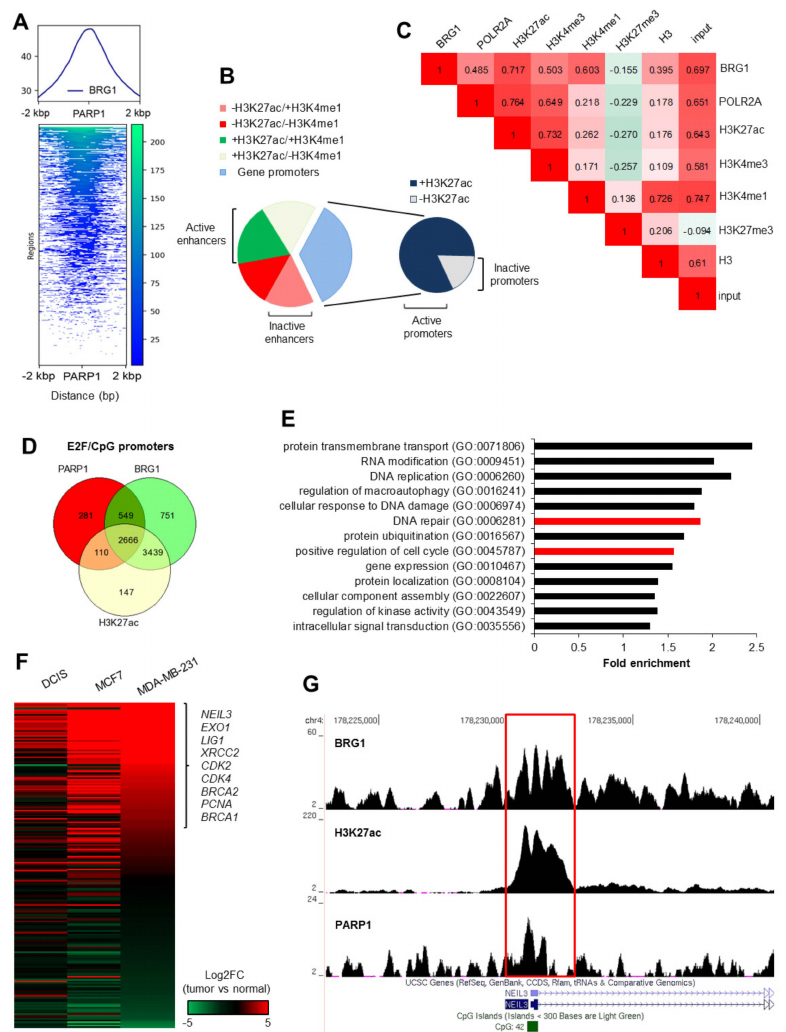
Figure 2. PARP1 co-occurs with BRG1 at the promoters of transcriptionally active genes in MDA-MB-231 cells. ( A ) An example computeMatrix / plotProfile plot of ChIP-Seq data for BRG1. BRG1 peaks are centered at PARP1-enriched regions in the genome of the MDA-MB-231 cell. ( B ) Association of PARP1 / BRG1 peaks with gene regulatory regions shows a prevailing occurrence at the active gene promoters. Enhancers emerged based on H3K27ac / H3K4me1 status, whereas promoters were assumed as TSS ± 2 kbp. PARP1 / BRG1-enriched regions were assigned to particular groups and quantified by bedtools Intersect intervals. ( C ) BRG1 distribution at the PARP1 peaks reveals a relatively strong correlation with histone markers and with POLR2A, which is typical for actively transcribed genes (multiBamSummary / plotCorrelation; PARP1 peaks in bed for scoring). ( D ) Venn diagram showing that a high proportion of PARP1 positive gene promoters are characterized by the presence of BRG1 and strong acetylation of H3K27. ( E ) Triple-positive gene promoters identified in ( D ) represent a functional association with numerous intracellular processes. GO-enriched terms were identified in AmiGO2. ( F ) Di ff erential expression of genes from two selected GOs, i.e., DNA repair and positive regulation of the cell cycle (marked in red in ( E )) in cancer cells (DCIS – ductal carcinoma in situ, pre-invasive malignancy of the breast and two breast cancer cell lines: MCF7 and MDA-MB-231) versus normal cells, as quantified by Cu ff di ff . The heatmap shows Log2 of the calculated fold change (Log2FC; cancer versus normal cells). ( G ) UCSC Genome browser visualization of PARP1, BRG1, and H3K27ac enrichment using Model-based Analysis of ChIP-Seq data (MACS) (bigwig) at the NEIL3